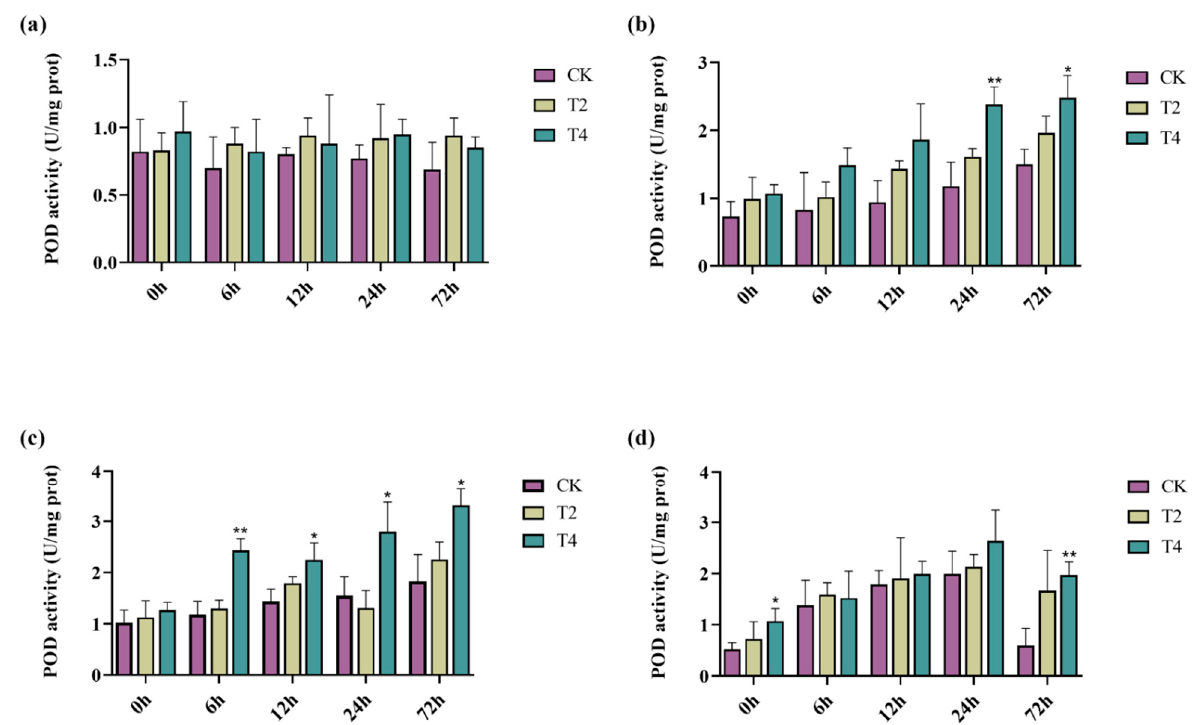
Figure 8. POD activity of transgenic and non-transgenic poplar plants subjected to different NaCl concentrations. Note: ( a ) without NaCl; ( b ) 100 mM NaCl; ( c ) 200 mM NaCl; and ( d ) 300 mM NaCl (The “*” above the histogram indicates significance. “*” indicates p < 0.05, “**” indicates p < 0.01).